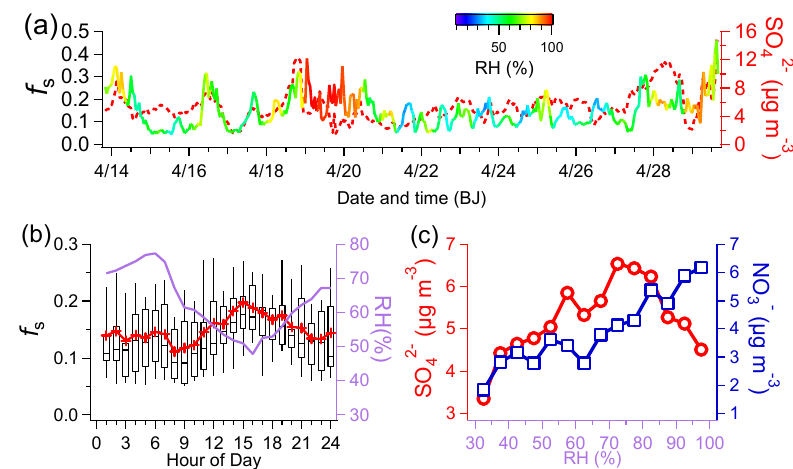
+ n SO / ( n SO 2 − 2 ), and sulfate; (b) diurnal variations of f S and RH (the 4 4